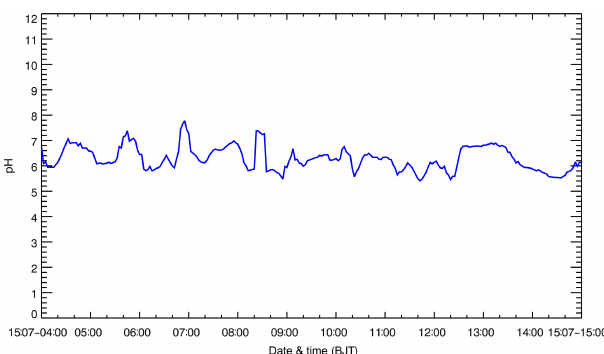
Figure 7. Temporal variation of the average simulated pH in Beijing from 4 to 15 July